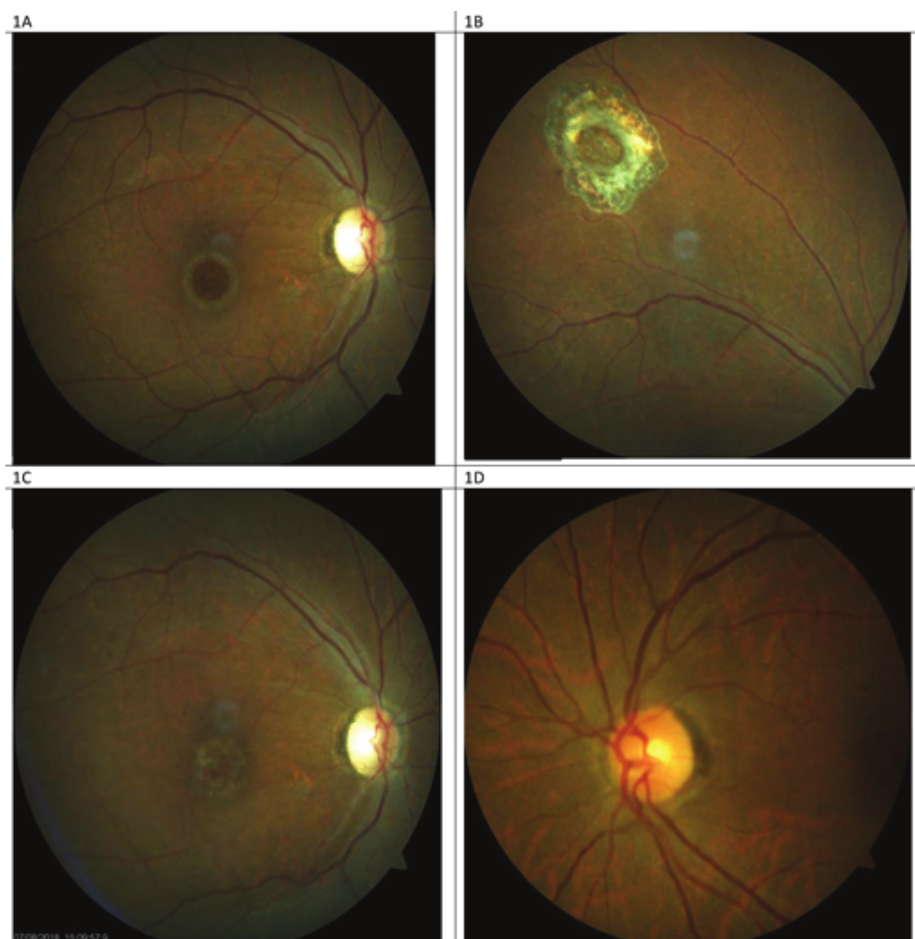
Figure 1. (A) Right eye preoperative fundus photograph showing the appearance of a recurrent macular hole occurring in patient 1; Pre-ART surgery. (B) Laser scar surrounding the site of neurosensory retinal harvest, anterior to the superotemporal arcade. (C) Post-ART surgery fundus photograph showing appearance of the free neurosensory retinal graft over the macular hole. (D) Normal-appearing left eye of the same